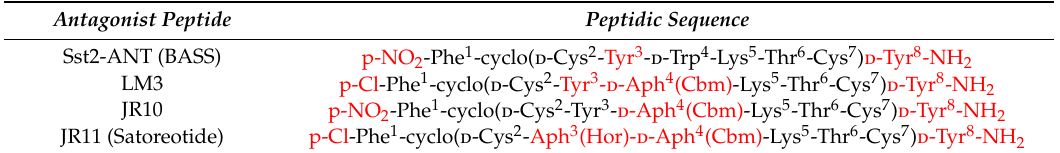
Table 4. Main somatostatin antagonist analogs. Di ff erences towards octreotide (OC) are highlighted in